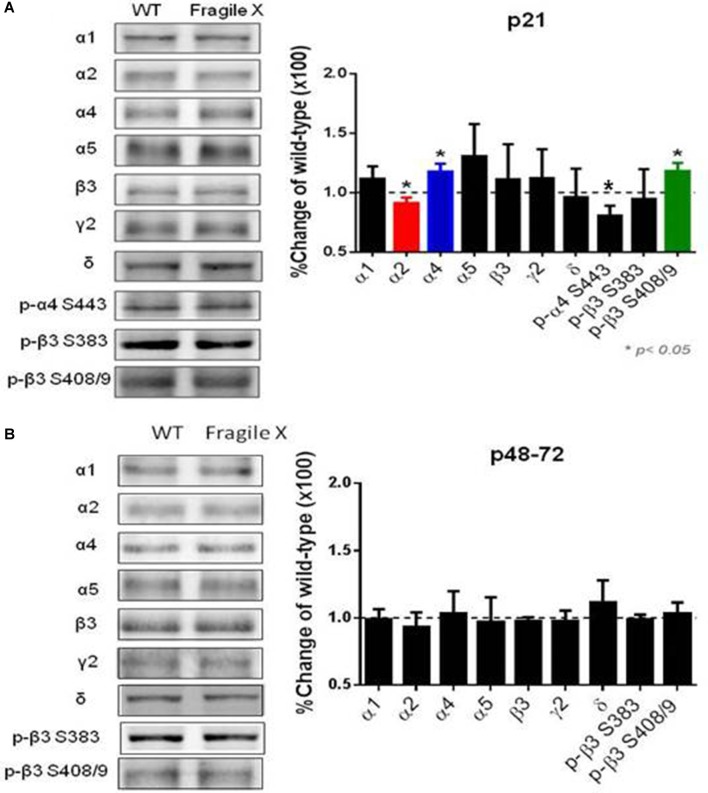
Comparison of GABAAR subunit expression and phosphorylation in Fmr1 KO mice. Fifty microgram of SDS-soluble hippocampal extracts from (A) p21, (B) p48-72 C57/BI6 Fmr1 KO mice, or WT controls were subject to immunoblotting with antibodies against the GABAAR, α1, α2, α4, α5, β3, γ2 and δ. Total subunit expression levels were then normalized to WT. In addition, extracts were immunoblotted with p-α4 S443, p-β3 S408/9 and p-β3 383 antibodies. The ratios of pS409/9/β3 and pS383/β3 immunoreactivity were compared and normalized to values seen in WT mice. *Significantly different to WT controls see text for p values (t-test; n = 3–8 mice).